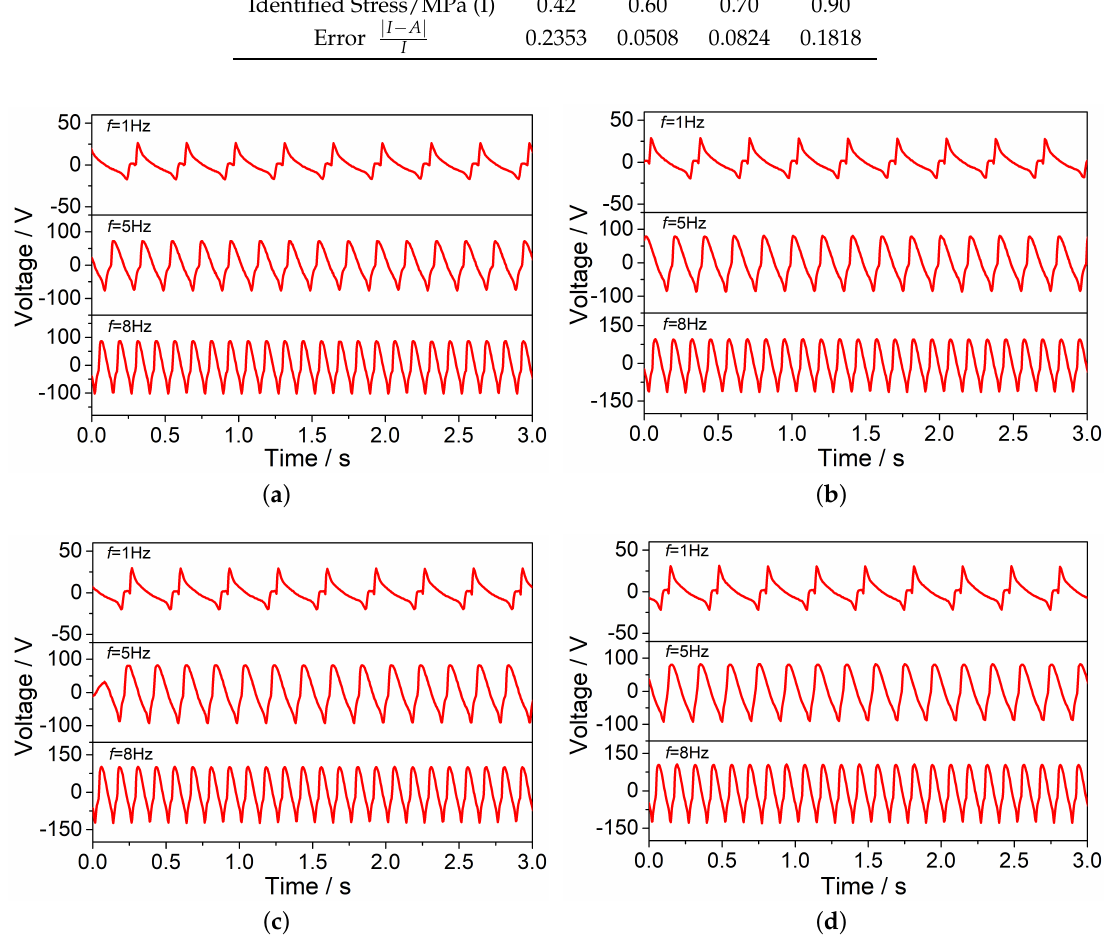
Figure 4. The voltage signals of the MTS test. ( a ) Voltage signals of No .1 PZT chip with three different loading frequencies under 45 kN load; ( b ) Voltage signals of No .1 PZT chip with three different loading frequencies under 54 kN load; ( c ) Voltage signals of No .1 PZT chip with three different loading frequencies under 63 kN load; ( d ) Voltage signals of No .1 PZT chip with three different loading frequencies under 72 kN